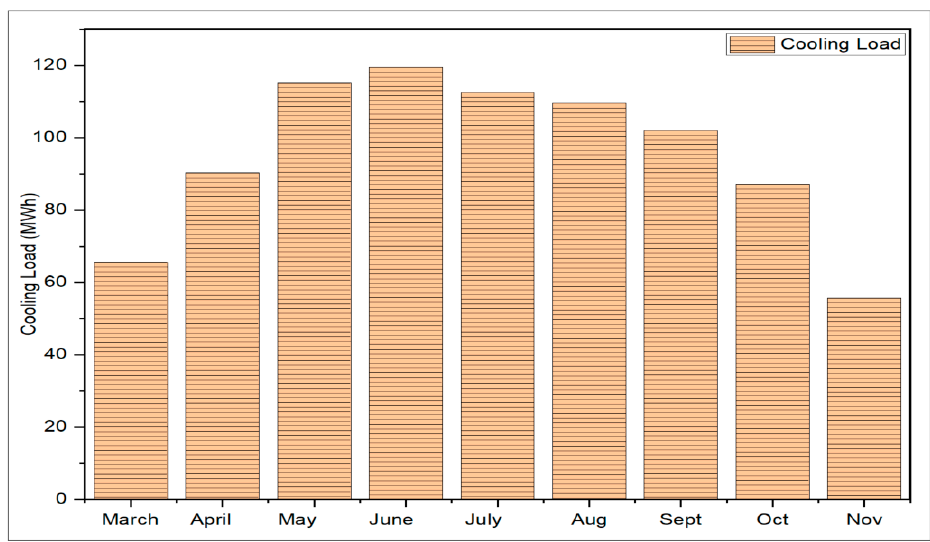
Figure 8. Monthly building cooling load.